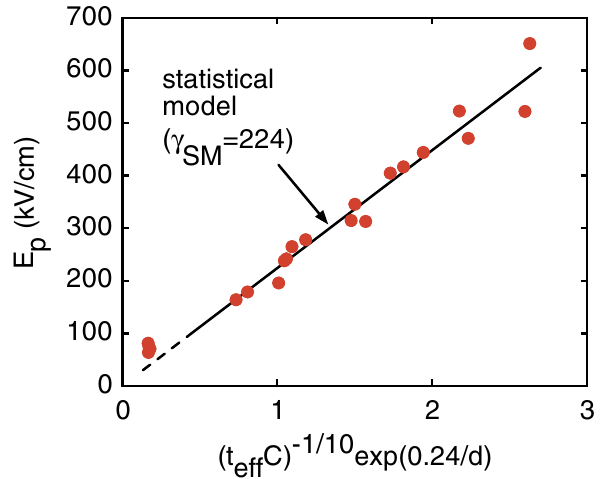
FIG. 5. (Color) The peak electric field E as a function of p (cid:3) t C (cid:4) (cid:2) 1 = 10 exp (cid:3) 0 : 24 =d (cid:4) , which is the statistical-model scaling, eff for conditions under which the flashover probability is approxi- is expressed in mately 50%. (The horizontal axis assumes t eff (cid:11) s , and C , d in cm.) The figure plots the 17 PMMA measure- (cid:12) 10 (cid:11) s and 0 : 5 (cid:12) ments listed in Table I with 0 : 5 ns (cid:12) t eff (cid:9) 90 s . This d (cid:12) 4 : 32 cm , and the four measurements with t eff is the same set of measurements used for Fig. 6. The fractional for the 17 measure- standard deviation in the values of (cid:24) SM ments is 7%. The 90-s measurements lie close together, and are < 100 kV = cm . The model the only measurements with E p ! 1 or C ! 1 , which are becomes inapplicable as either t eff ! 0 , since there exists a minimum equivalent to the limit E p electric field below which a flashover is not